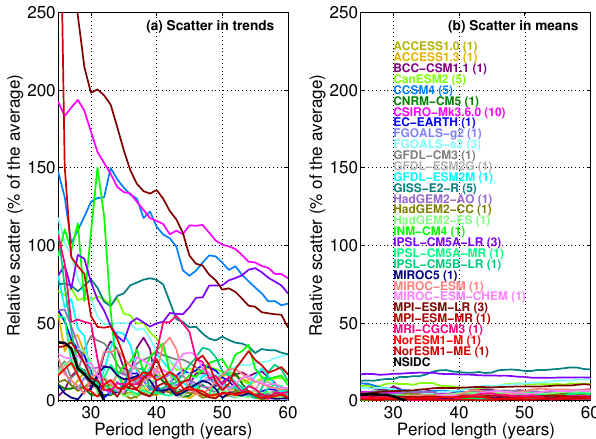
Fig. 5. Effects of internal variability on the trend in SSIE (a) and mean of SSIE (b) as a function of the length of the time series con- sidered. For a given period length x (e.g. x = 30yr), we construct 4 time intervals starting in 1979, 1980, 1981 and 1982 and ending x yr later (e.g. 1979–2009, 1980–2010, ..., 1982–2012). The trends (a) and mean (b) SSIE are then calculated for all available members of the same model over these 4 time intervals. The relative spread in the sample (the range divided by the average) is displayed as the y coordinate. The observations (black) are treated like a model, but with one member (by definition), thus simply changing the end